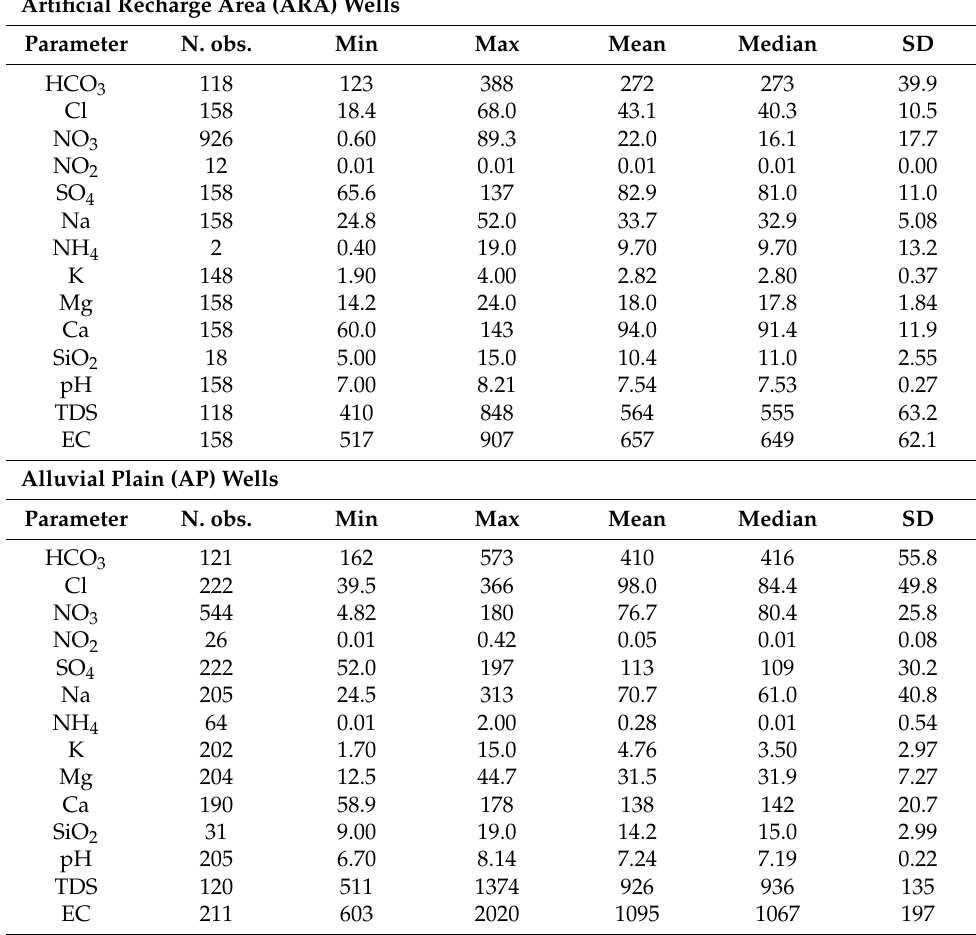
Table 1. Main summary statistics of the available data for the ARA (upper panel) and AP (lower panel) monitored wells, respectively. N. Obs. = number of available measurements; Min = minimum value; Max = maximum value; Mean = average value; Median = median value; SD = standard deviation. Data are expressed in mg/L. Artificial Recharge Area (ARA) Wells N. obs.